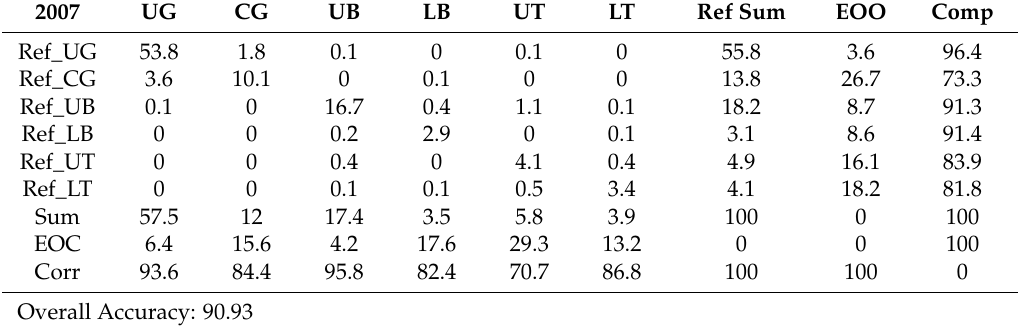
Table 4. Confusion matrix of the classification result for the 2007 and 2015 datasets. The rows correspond to the reference classification, the columns to the automatic classification. EOO, Error of Omission; Comp, Completeness; EOC, Error of Commission; Corr, Correctness; UG, unchanged ground; CG, changed ground; UB, unchanged building; LB, lost building; NB, new building; UT, unchanged tree; LT, lost tree; NT, new tree.